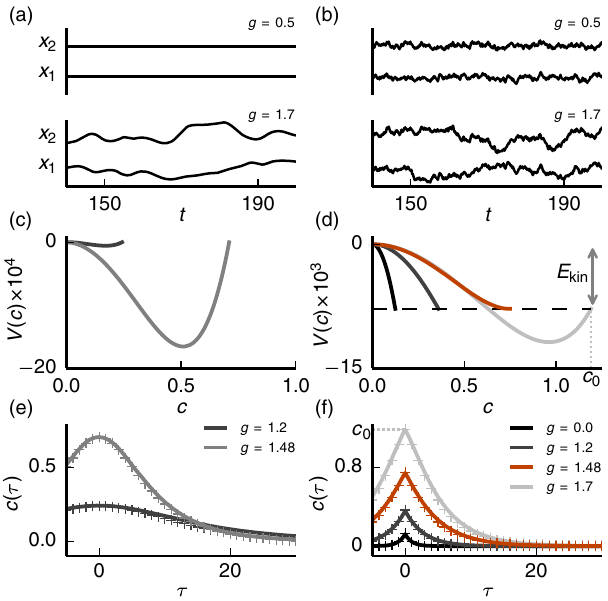
FIG. 1. Activity statistics of the autonomous and driven net- works. The autonomous case is for σ ¼ 0 (left column), and the driven case is for σ ¼ 0 . 35 (right column). Upper row: Simulated trajectories of two example neurons for subcritical g ¼ 0 . 5 (upper part of vertical axis) and supercritical coupling g ¼ 1 . 7 (lower part of vertical axis). Middle row: Classical potential (10) with self-consistently determined variance c 0 following from energy conservation (11) for different coupling strengths g (correspond- ing legends in lower row). The dashed horizontal line indicates σ 4 = 2 . In the driven case, the minus initial kinetic energy E kin ¼ 1 . 48 from Eq. (20) is shown in red. Lower critical coupling g c ¼ row: Self-consistent autocorrelation function (solid curve) com- pared to simulations (crosses). The variance (peak height) c 0 corresponds to the largest value of c at which the potential (middle row) is defined, indicated for g ¼ 1 . 7 with gray dotted lines in (d) and (f). The network size in the simulations is N ¼ 10 000